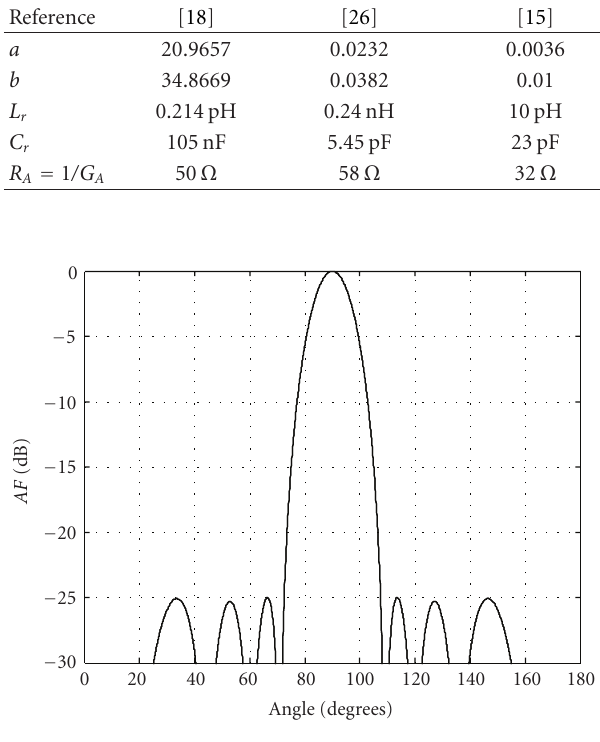
Figure 4: The attained pattern for the general design case.